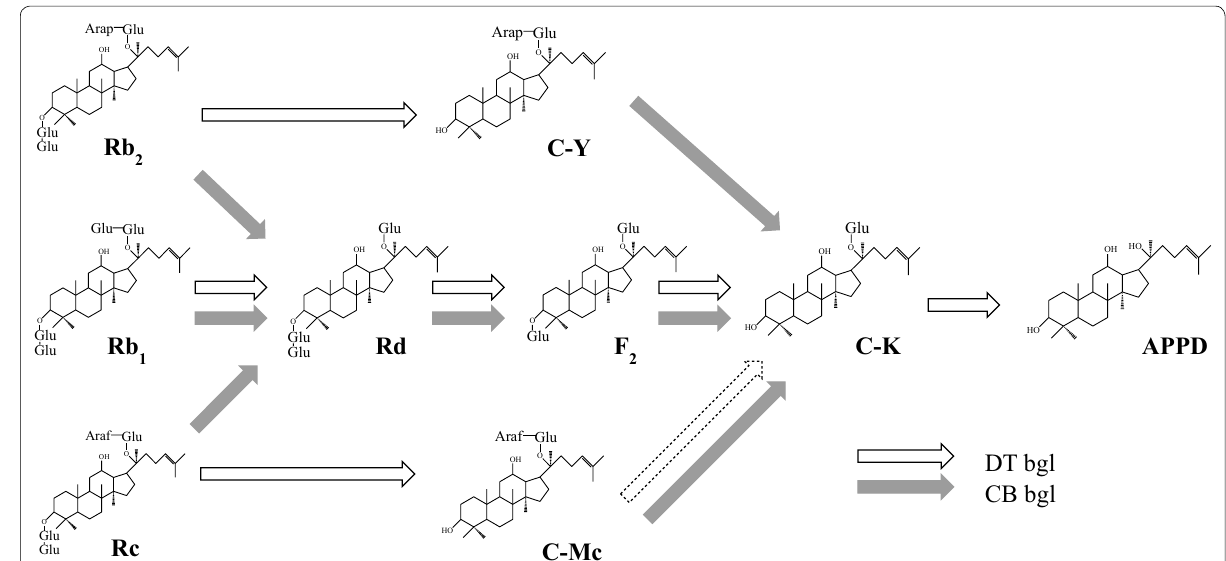
Fig. 4 Biotransformation pathway for the conversion of ginsenosides Rb 1 , Rb 2 , and Rc to APPD via Rd, F 2 , C‑K, C‑Y, and C‑Mc by DT‑bgl supple‑ mented with CB‑bgl. The dotted line indicates a weak activity